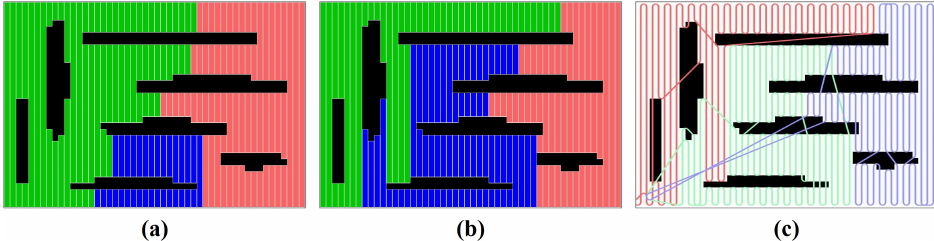
Figure 8. ( a ) Initial partition. ( b ) Partition refinement. ( c ) Path Planning.